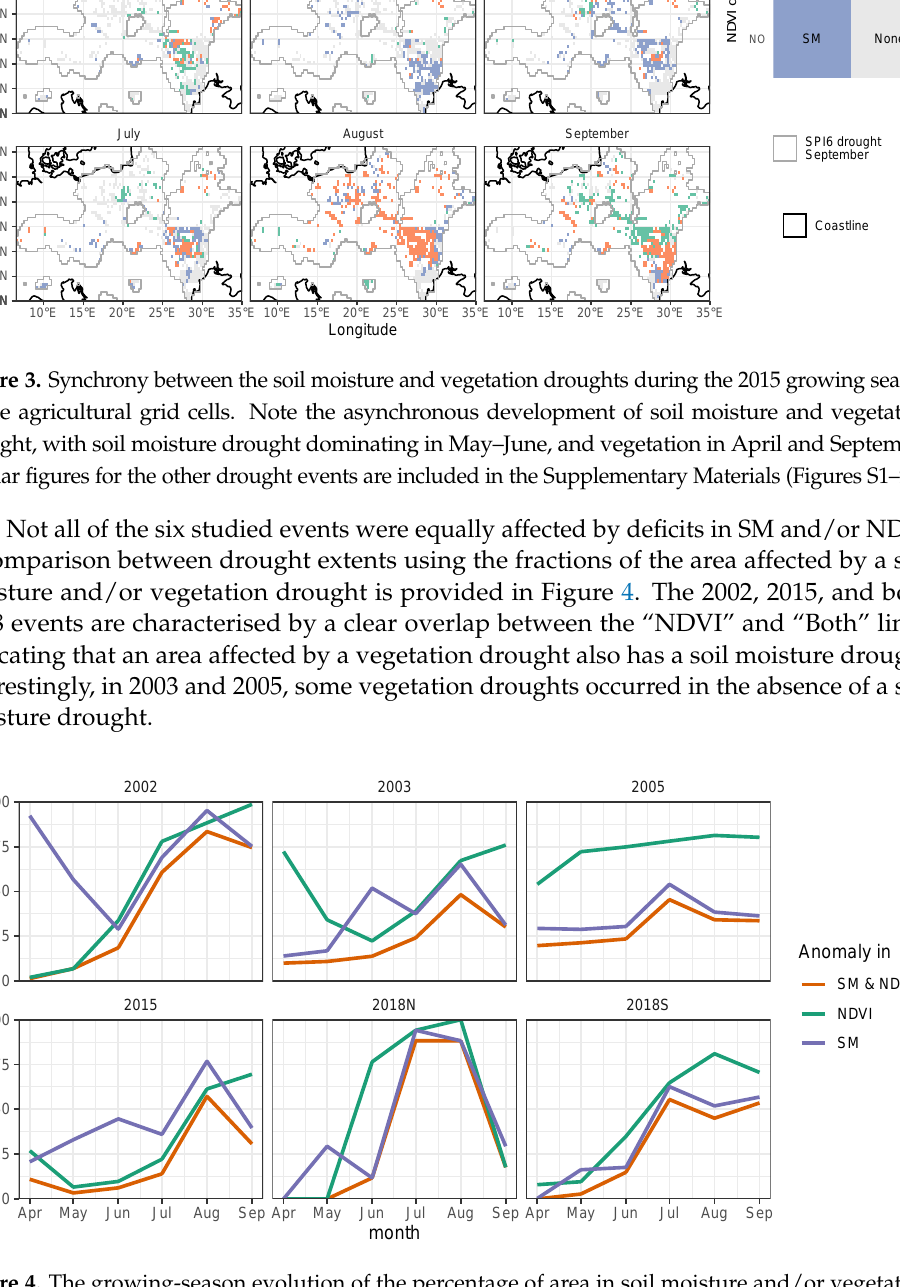
Figure 4. The growing-season evolution of the percentage of area in soil moisture and/or vegetation drought in the selected agricultural grid cells in each studied meteorological drought event. Panels show the six events, where the vegetation (NDVI, green) and soil moisture (SM, purple) grid cells in drought (defined as an anomaly < − 1) are shown separately, as well as the percentage of grid cells affected by droughts in both variables simultaneously